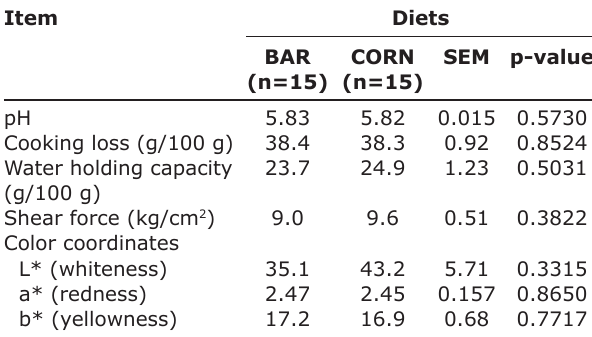
BAR=Barley, CORN=Corn, SEM=Standard error of the mean Table-7: Effects of feeding either BAR or CORN grains on meat quality of Awassi lambs.